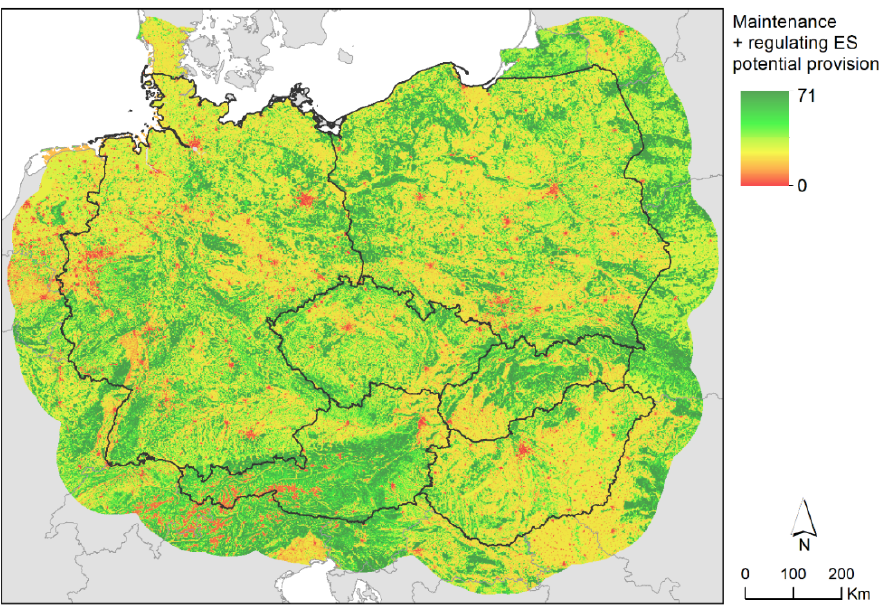
Figure 2. Weighted capacity to supply maintenance and regulating ES in regular grid with cell size 1 km 2 .